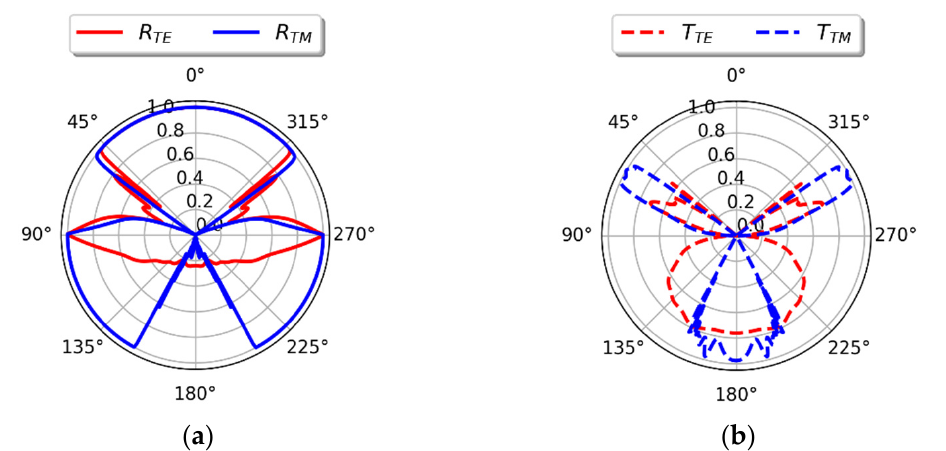
Figure 8. Reflectance ( a ) and transmittance ( b ) of the proposed optical diode plotted vs. angle of incidence at fixed wavelength λ 0 = 600 nm.